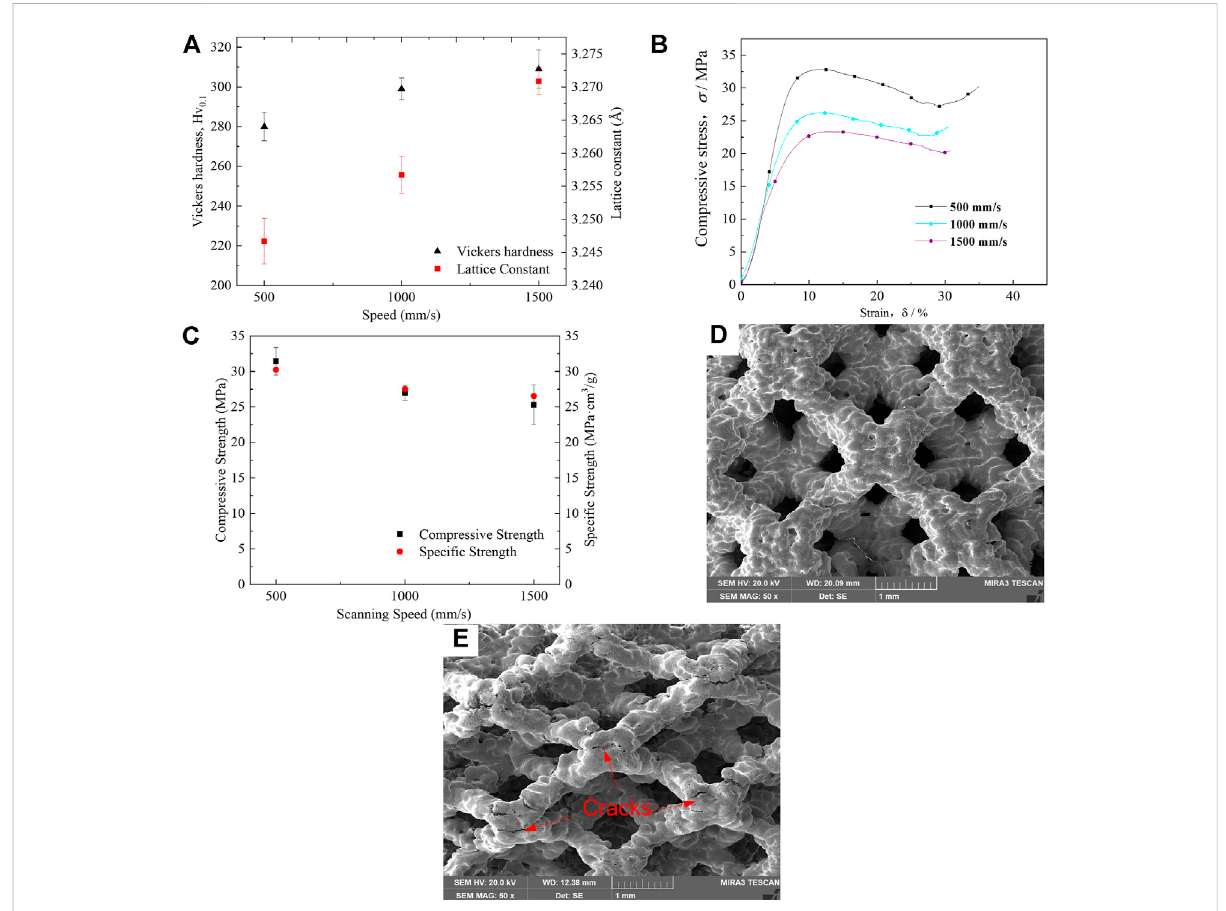
FIGURE 8 Lattice constant and microhardness (A) , the compressive stress-strain curves of the materials with different scanning speeds (B) , compressive strength and speci fi c strength for SLM porous Ti-55531(Fe) alloys with different laser scanning speeds (C) , SEM micrographs of materials with scanning speed of 1,000 mm/s in pre-compression (D) and post-compression state (E) ,